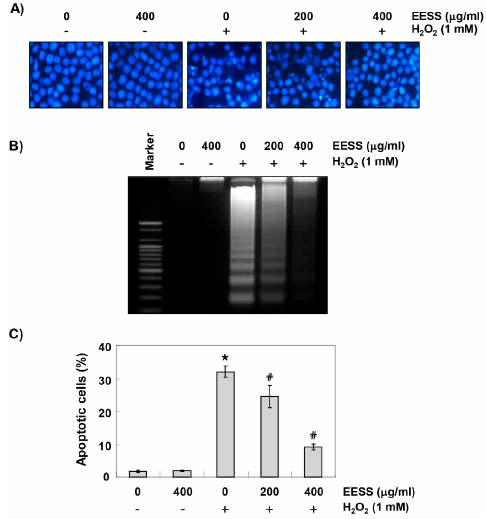
Figure 4. Suppression of H 2 O 2 -induced apoptosis by EESS in SW1353 chondrocytes. Cells were pretreated with or without EESS for 1 h, prior to 1 mM μ M H 2 O 2 for 24 h. ( A ) The cells were fixed and stained with DAPI solution. After 10 min incubation at room temperature, the stained nuclei were observed using a fluorescence microscope (original magnification, 400×); ( B ) DNA fragmentation was analyzed by extracting genomic DNA, electrophoresis in a 1.5% agarose gel, and then visualized by EtBr staining. ( C ) The cells were collected and stained with annexin-V and PI, and the percentages of apoptotic cells were then analyzed using flow cytometric analysis. The results are the means ± SD obtained from three independent experiments (* p < 0.05 compared with the control group; # p < 0.05 compared with the H 2 O 2 -treated group).